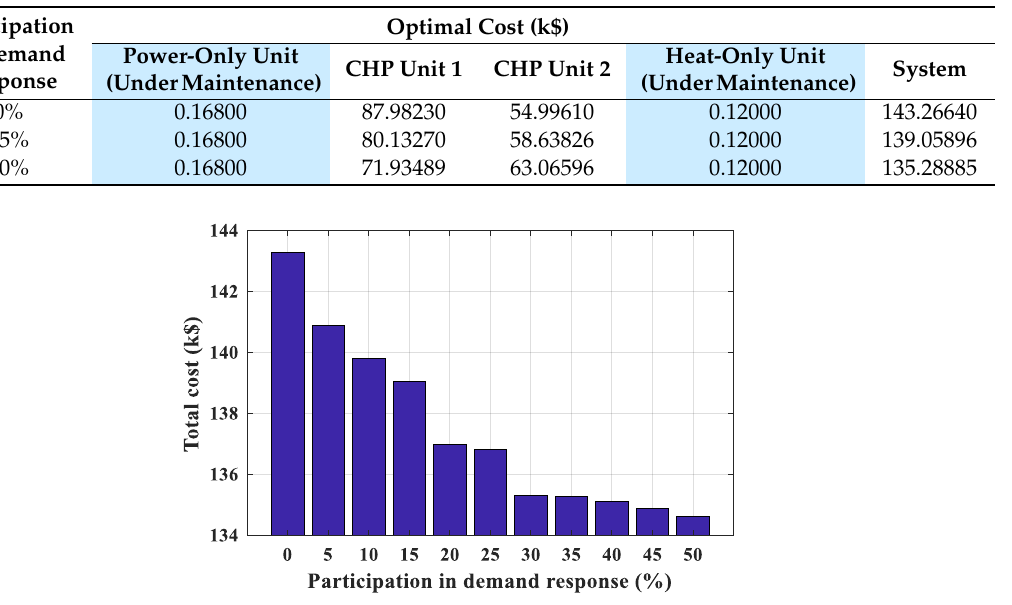
Figure 13. Decreasing trend of the total cost of the system for a typical day in week 32 respect to demand response.